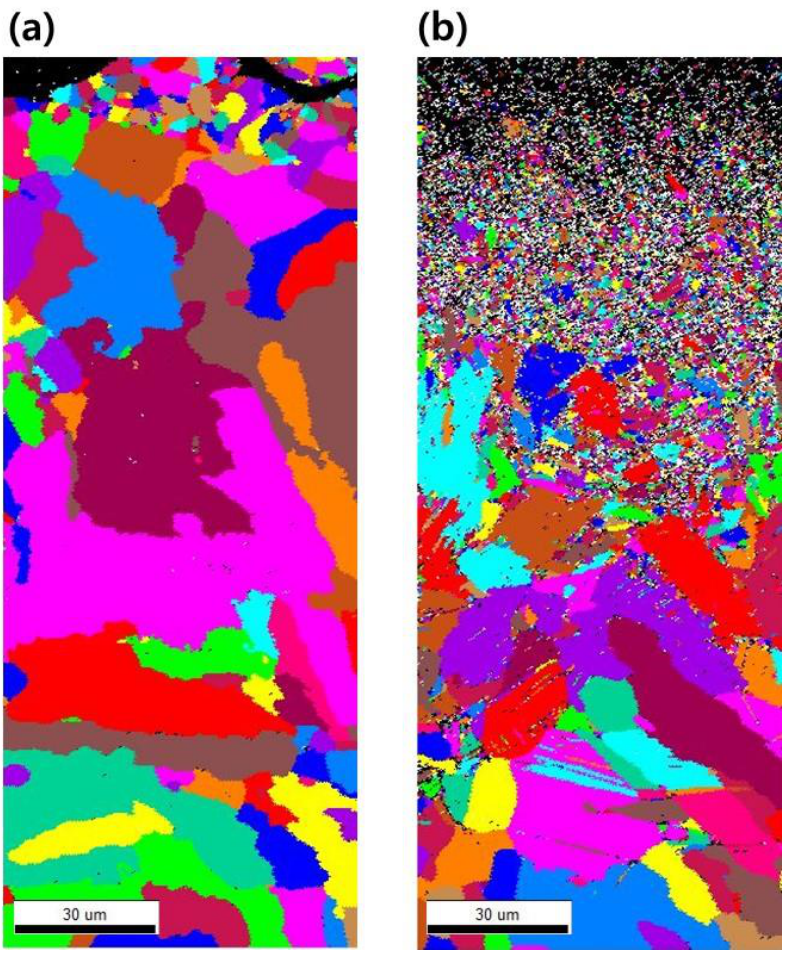
Figure 11. EBSD results of microstructure near UNSM treated surface: ( a ) before and ( b ) after treatment.